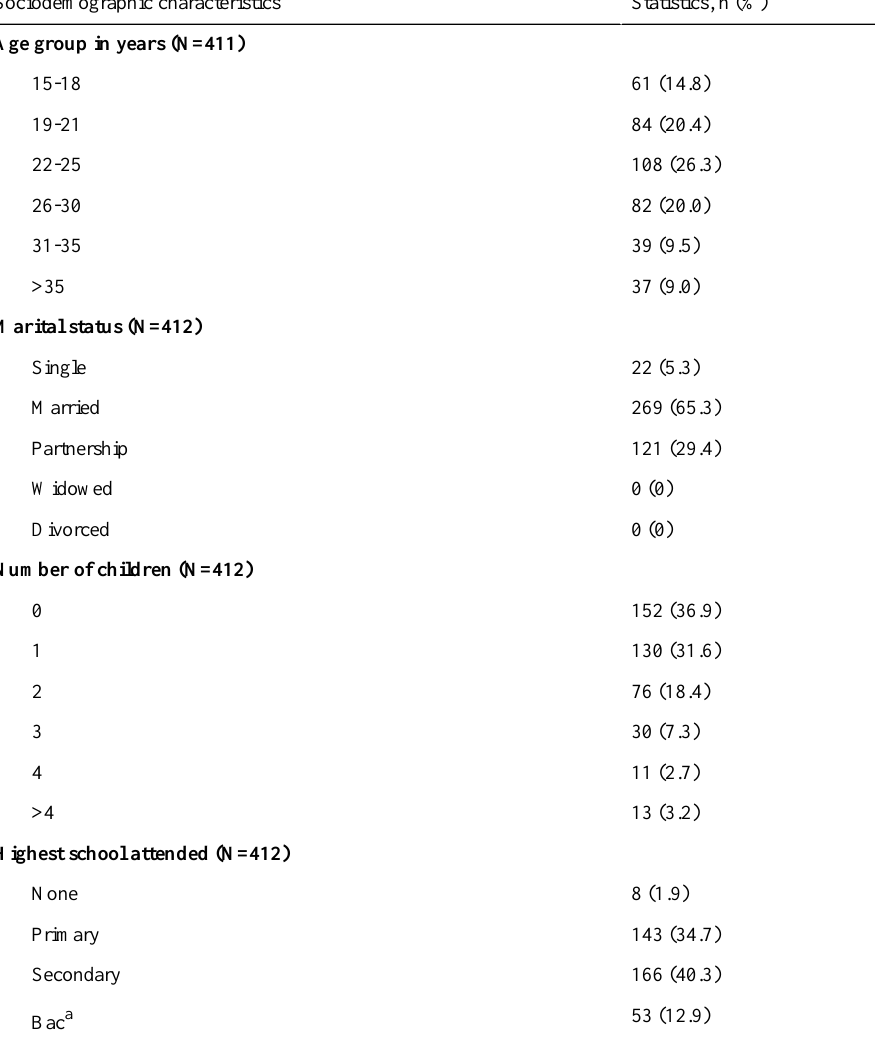
Table 1. Selected characteristics of study participants in the quantitative